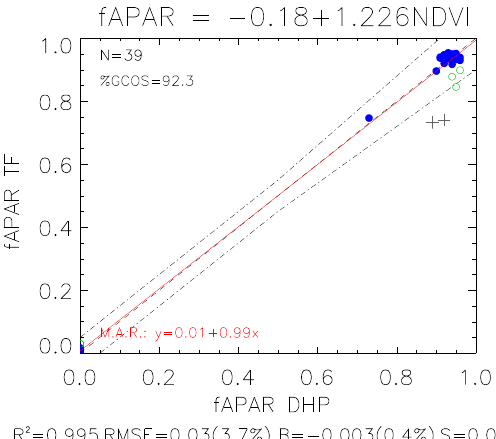
Figure 8. Scatter-plot of ground-based map data (fAPAR-TF) vs. ground estimates (fAPAR DHP ). Filled blue dots: Weight > 0.7. Empty green dots: 0 < Weight < 0.7. Grey crosses: outliers. First field campaign on 8 July 2015 and second field campaign on 25 September 2015. Number of samples (N), Major Axis Regression (M.A.R.), correlation (R 2 value), RMSE, bias (B), standard deviation (S), and percentage of values matching the GCOS requirements (%GCOS) are displayed. Dashed lines correspond to the 1:1 line and GCOS uncertainty levels; the red continuous line corresponds to the M.A.R.